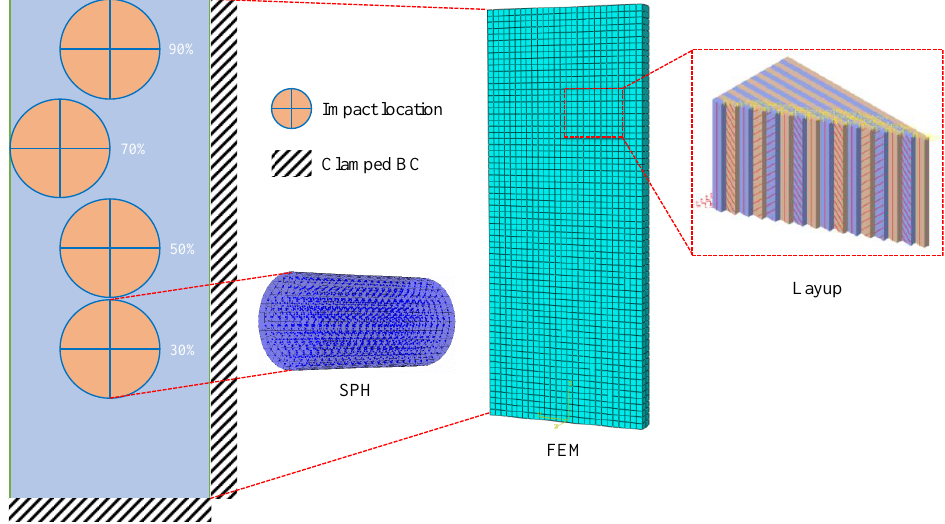
Figure 2. SPH/FEM model and simulation cases for bird-strike impact (BC: boundary condition).